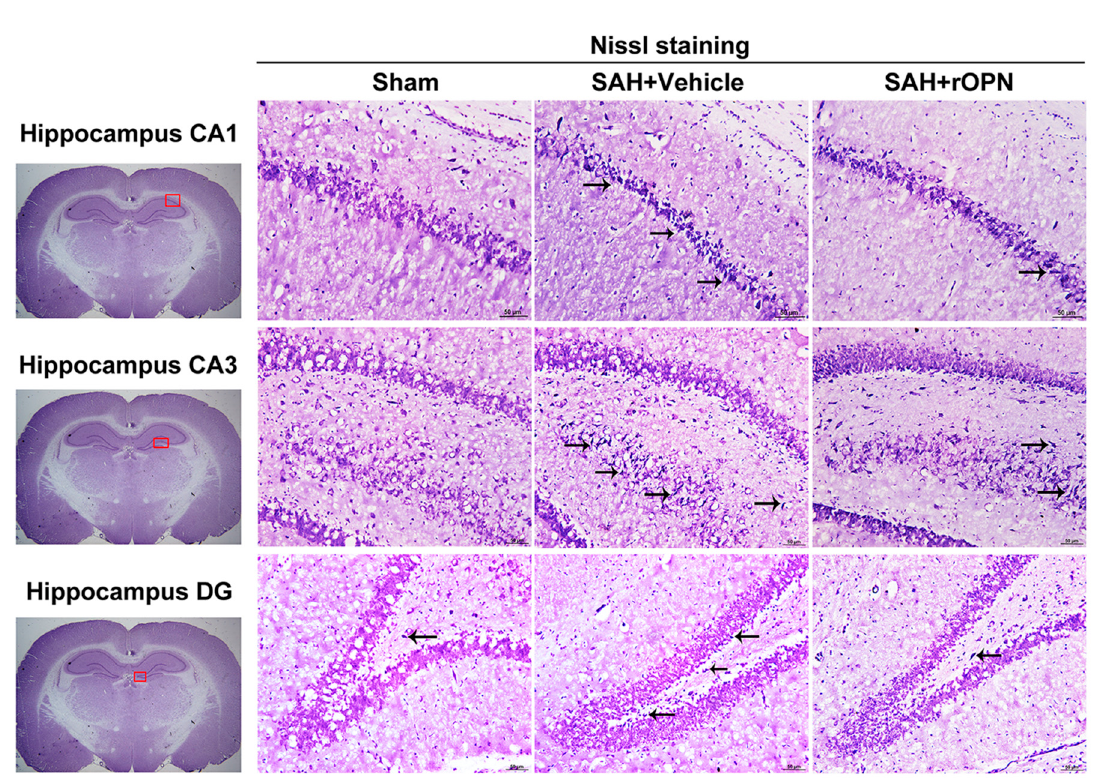
Figure 7. The effects of recombinant osteopontin (rOPN) administration on long-term Nissl staining results after SAH. rOPN decreased the amount of degenerative neurons and attenuated hippocampal injury in the CA1, CA3, and DG sectors in long-term SAH + rOPN rats. n = 3 per group. The red boxes in the brain slices images (left side) indicate the locations observed. Arrows indicate degenerative neurons with shrunken cytoplasm and condensed staining. Scale bar = 50 µ m. DG, dentate gyrus.